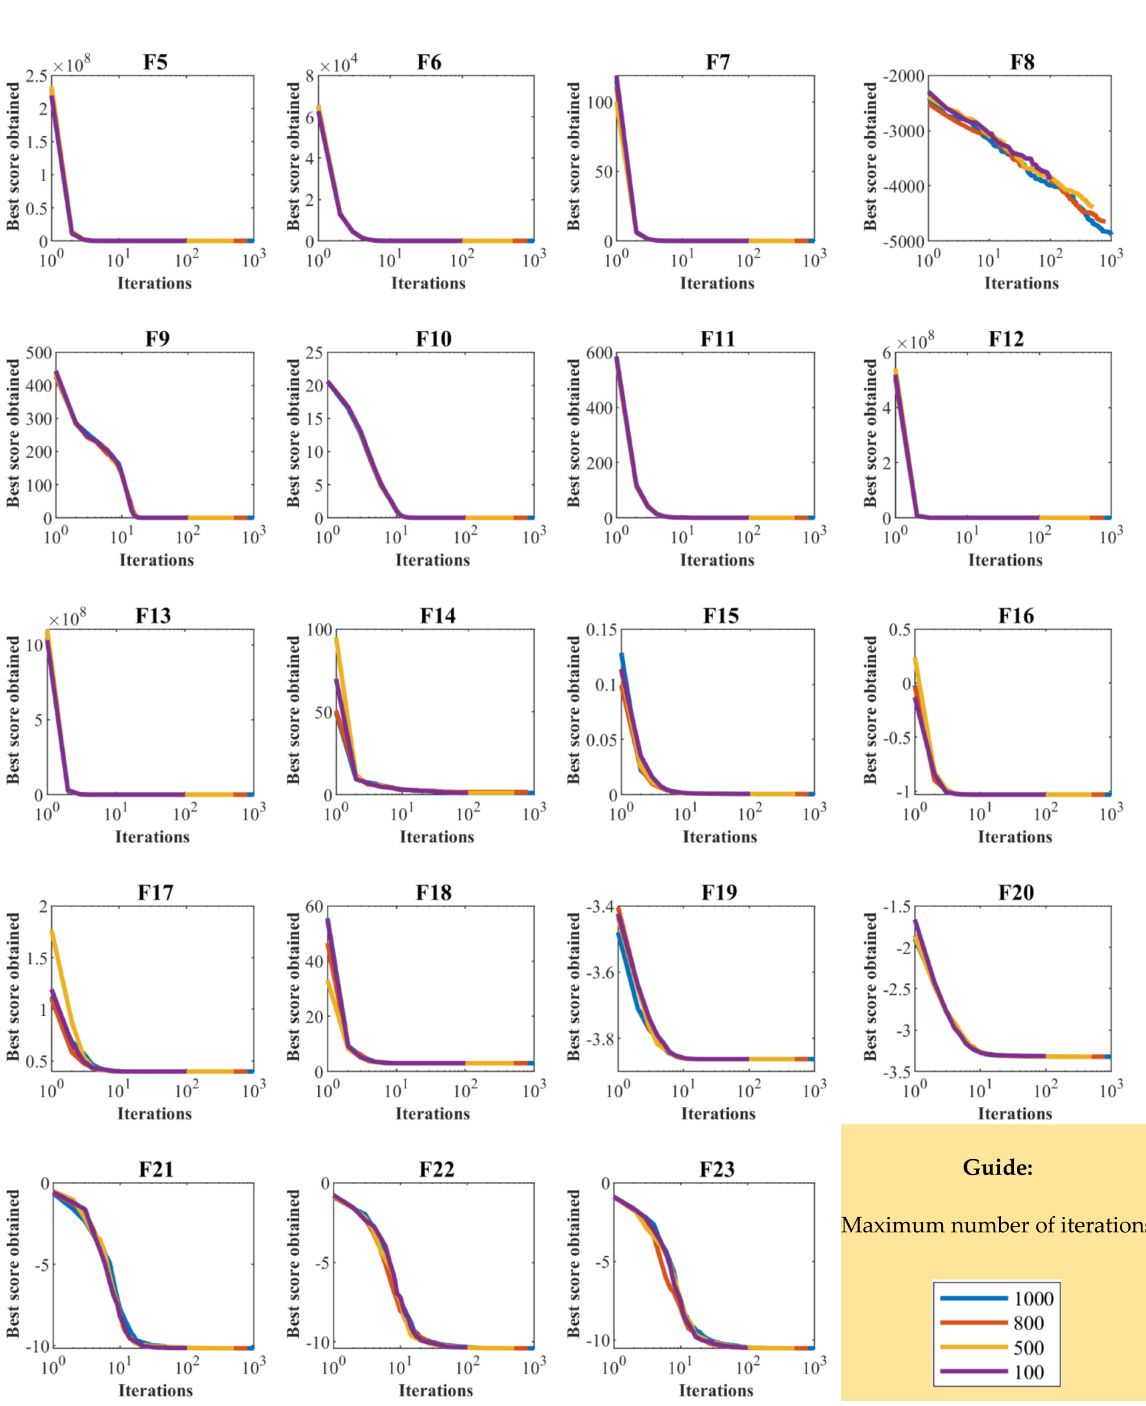
Figure 3. Sensitivity analysis of SLOA for maximum number of